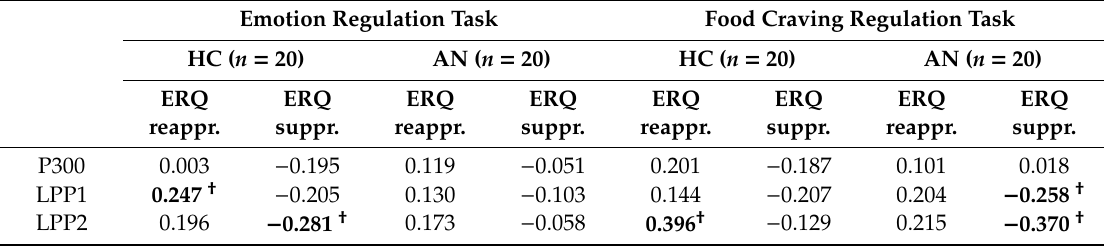
Table 5. Pearson’s correlation between the amplitudes ( µ V) of the P300, LPP1, LPP2 during the “regulate” condition of the emotion regulation and the food craving regulation